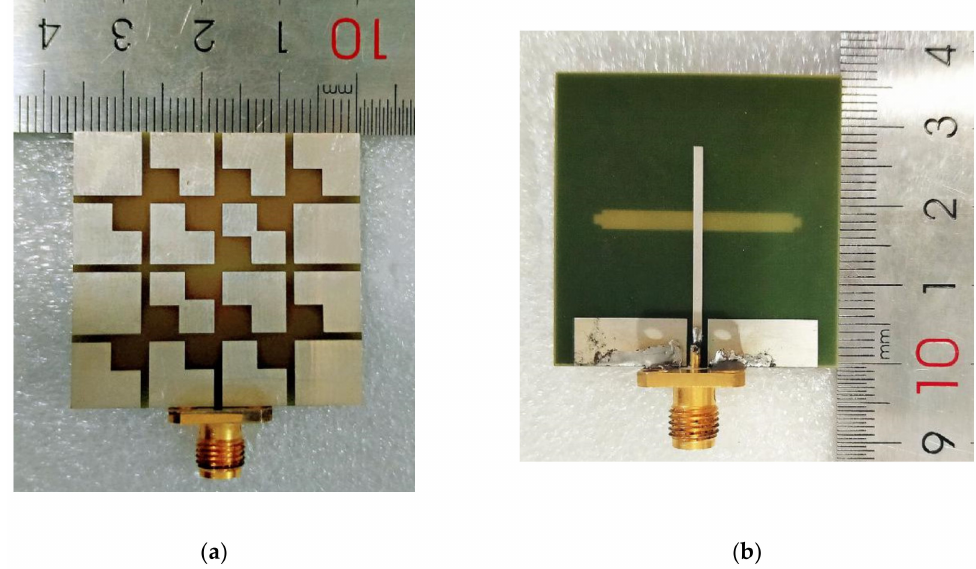
Figure 7. Photographs of the fabricated metasurface antenna: ( a ) top view; ( b ) rear